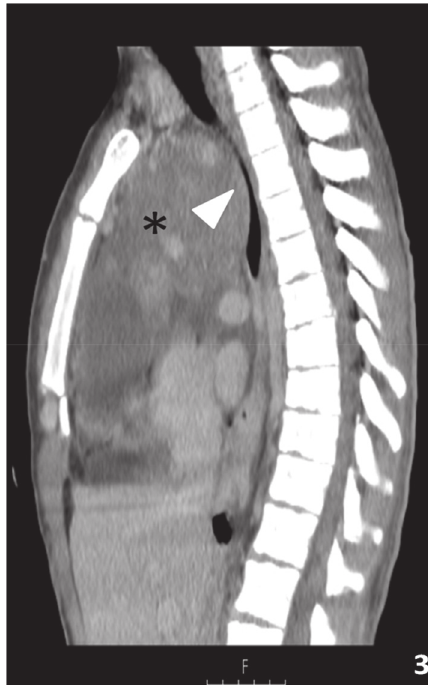
Figure 3: Contrast-enhanced computer tomography (CECT) with sagittal reformat shows a bulky anterior mediastinal mass (black asterisk). The mass also deviates from the aortic arch and the trachea (white arrowhead), with a marked reduction of the tracheal